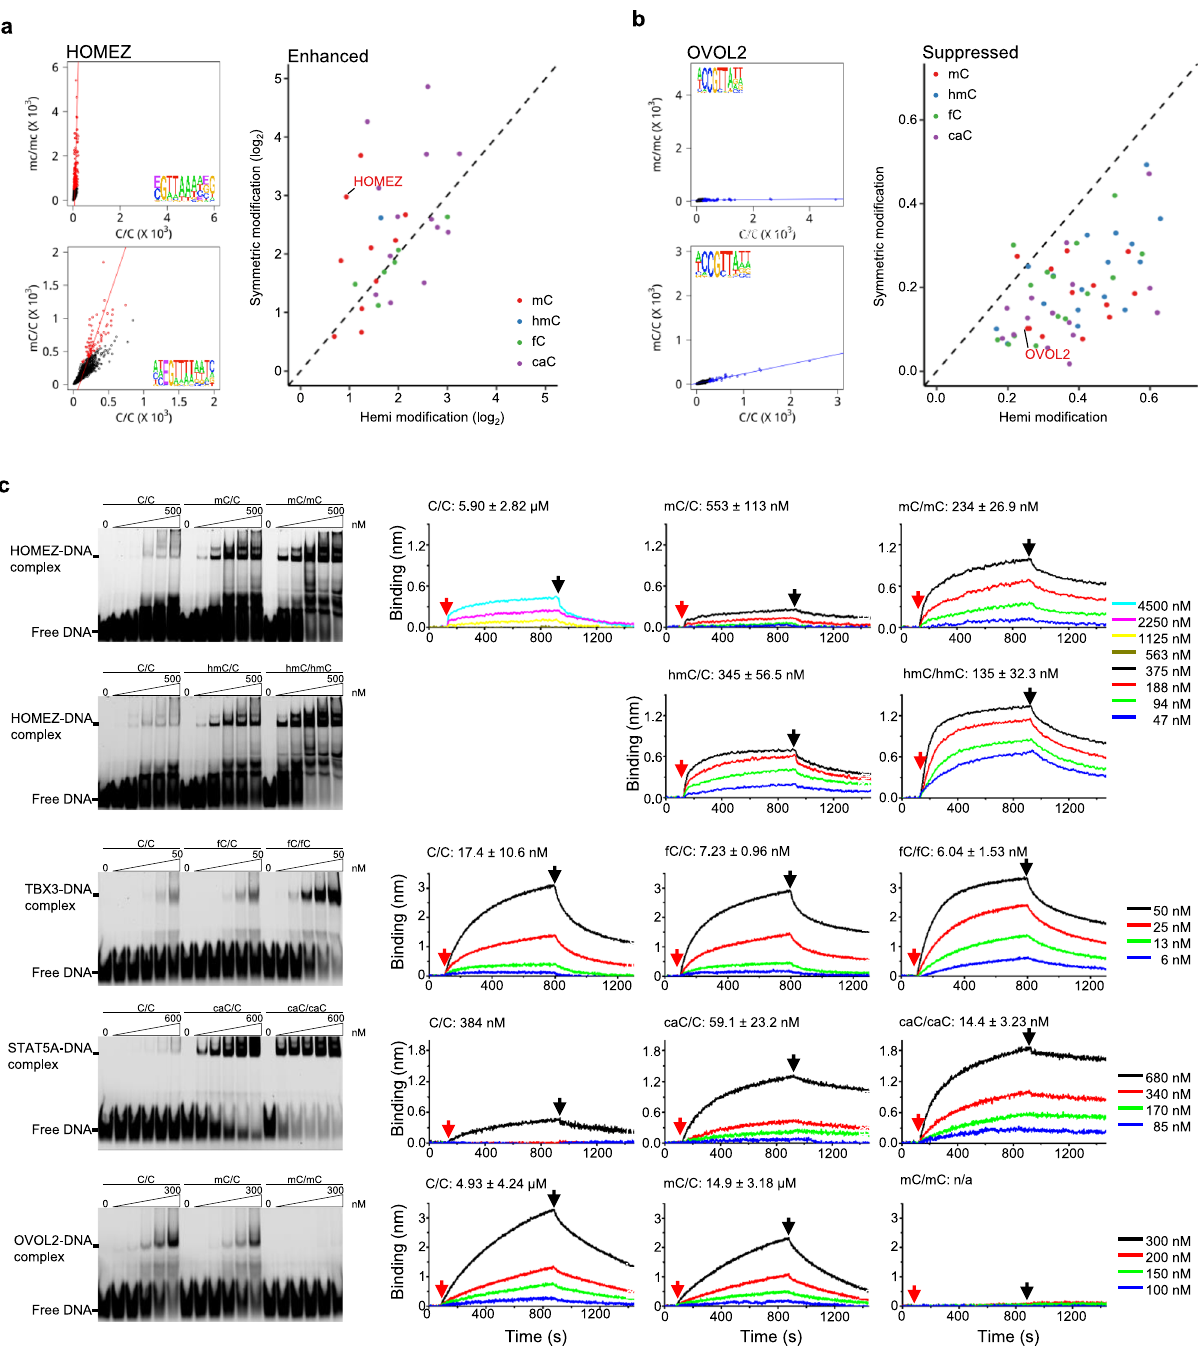
Fig. 6 Symmetric modi fi cations have a greater impact on TF-DNA interactions than hemi-modi fi cations. a Symmetric modi fi cations enhance TF ’ s binding to modi fi ed consensus sequences more than hemi-modi fi cations. The enriched 6-mers (red dots) show a steeper slope for symmetric methylation than hemi-methylation, although methylation in both symmetric and hemi-forms enhanced HOMEZ ’ s binding activity. In 16 (53.33%) of the 30 modi fi cation-enhanced cases symmetric modi fi cations showed higher slopes than the hemi-modi fi cations. Letter E in the consensus sequences represents modi fi ed cytosine. b Hemi-modi fi cations suppress TF ’ s binding to modi fi ed consensus sequences less than symmetric modi fi cations. The suppressed 6- mers (blue dots) show a fl atter slope for symmetric methylation than hemi-methylation for OVOL2. In 58 (96.7%) of the 60 modi fi cation-suppressed cases symmetric modi fi cations showed fl atter slopes than the hemi-modi fi cations. c Binding kinetics and af fi nity studies. Electrophoretic mobility shift assays (EMSA) were used to obtain semi-quantitative measurements of interactions between modi fi ed DNA motifs and the corresponding TFs at various concentrations. The DNA probe for HOMEZ ’ s EMSA validation was designed by assembling the six 6-mer sequences with the highest frequency. The OCTET system was employed to determine binding kinetics and af fi nity values for DNA-TF interactions as described above. The red and black arrows indicate when the DNA probe immobilized on an OCTET biosensor was dipped into TF solution and wash buffer, respectively. The deduced K D values are listed for each assay performed at various TF concentrations shown in different colors. DNA oligo sequences used for the EMSA and OCTET were shown in Supplementary Table 1. Source data are provided as a Source Data fi